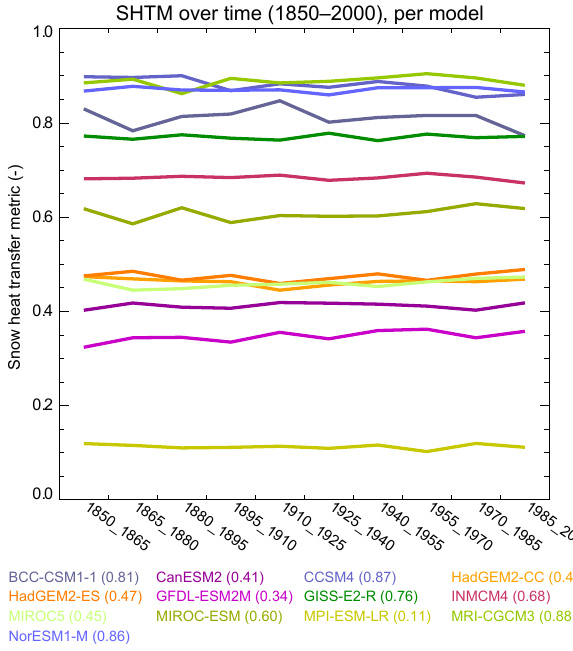
Figure 6. Mean value of the snow and heat transfer metric (SHTM) for each model. Values closer to 1.0 indicate better agreement with observations. SHTM values are relatively stable over 150 years of climate for each